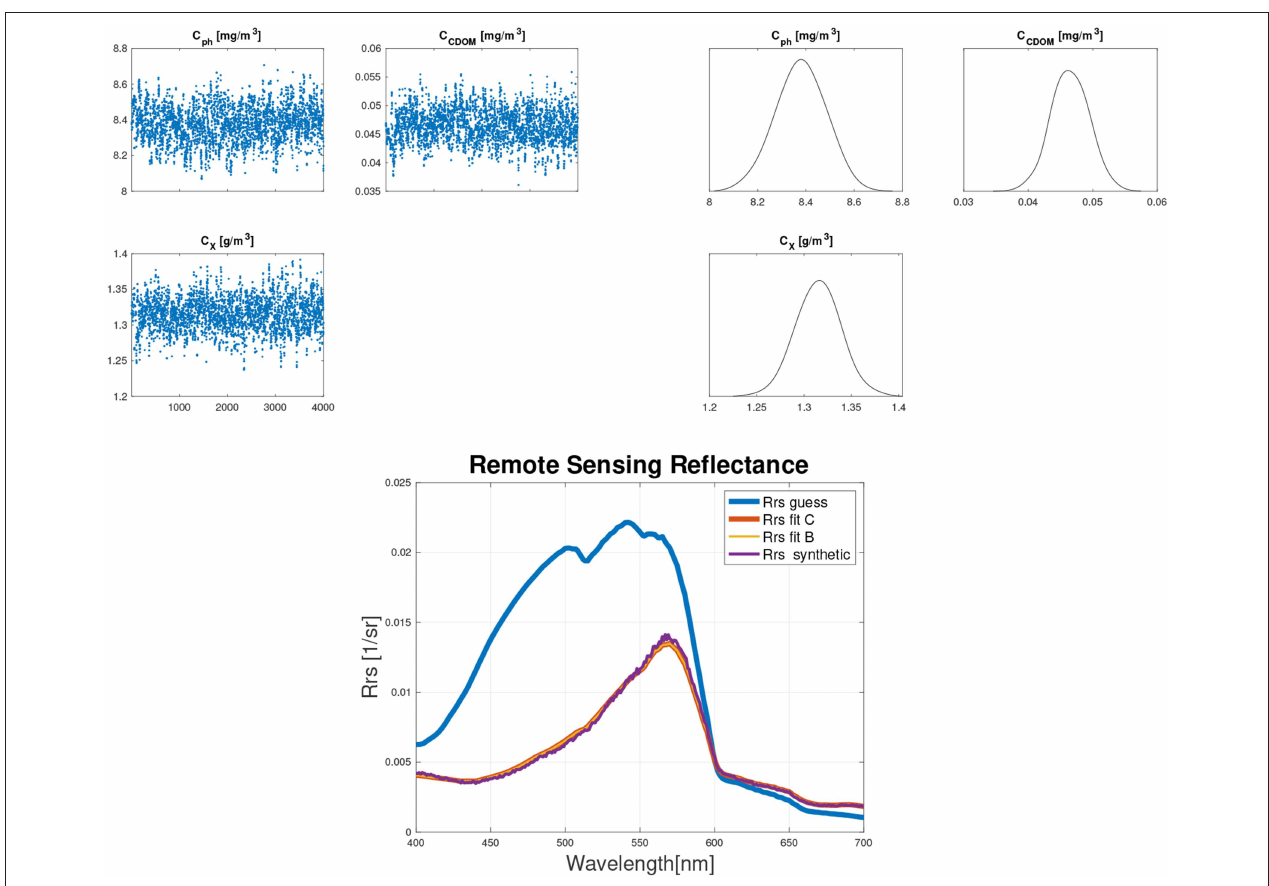
FIGURE 7 | Results for example 1: sampled concentrations, where in the x–axis the number of MCMC samples are reported (top–left) , posterior distributions (top–right) , and real remote sensing reflectance vs. simulated ones (bottom) .